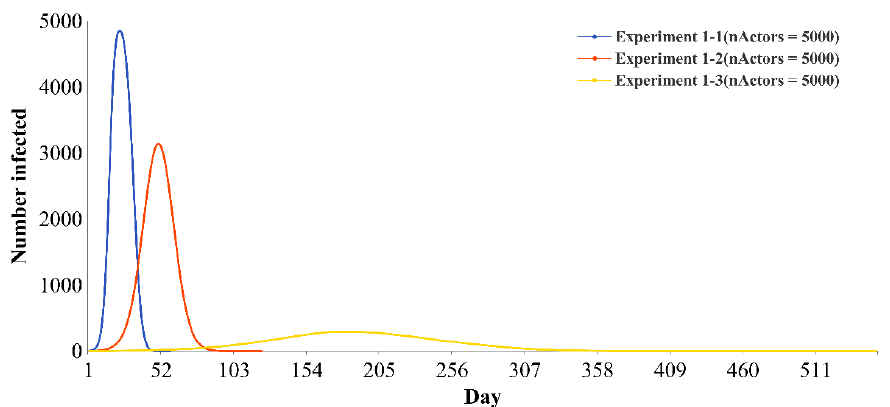
Figure 8. Infection curves of the basic experiments with 5000 individuals.